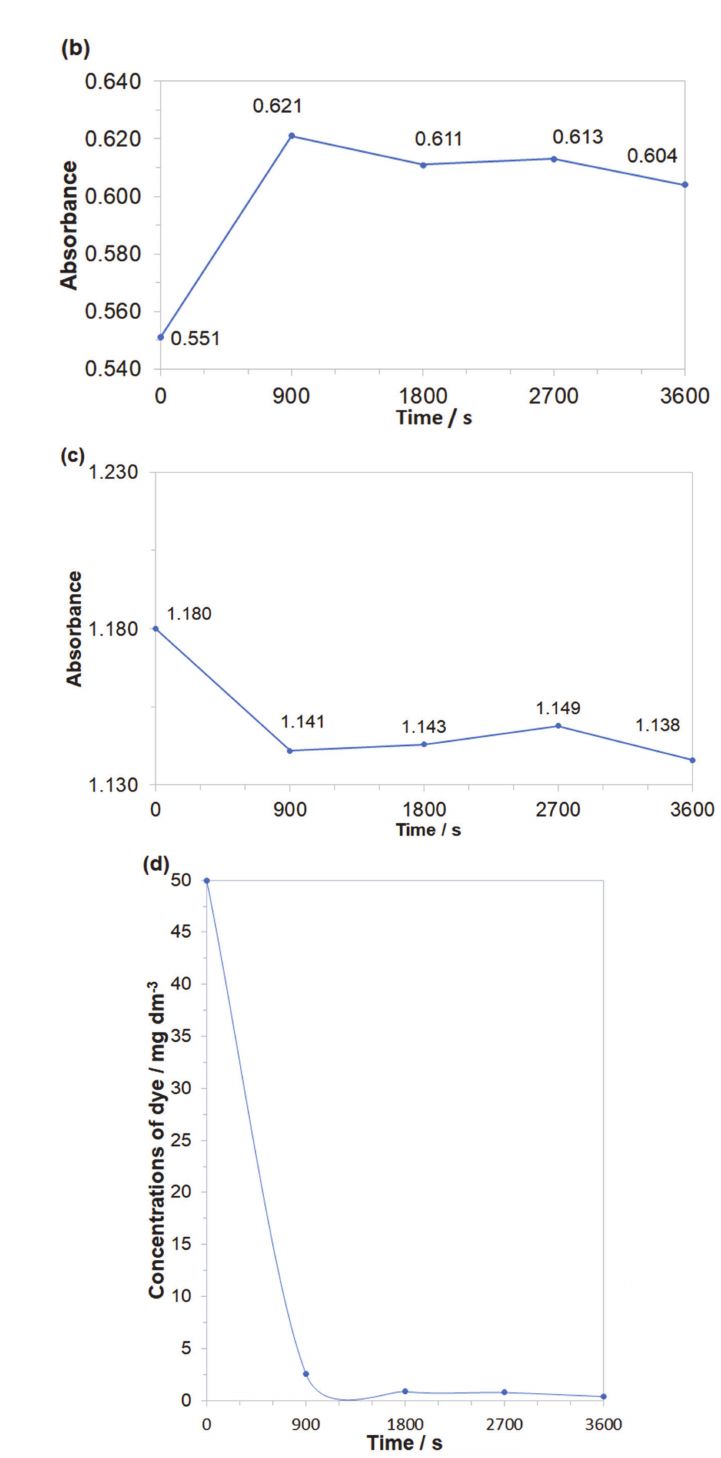
Figure 7. Representation of the three segments of dye electrooxidation process on the surface of Al alloy anode in Na 2 SO 4 -based Disperse Red 167 solution (at the concentration of 50 mg dm − 3 ): ( a ) Evolution of decolourization process recorded for the wavelength of 470 nm; ( b ) Progress of aromatic ring degradation for the wavelength of 280 nm; ( c ) Evolution of mineralization process recorded for the wavelength of 240 nm; ( d ) Quantitative dye assay after sedimentation process for the wavelength of 470